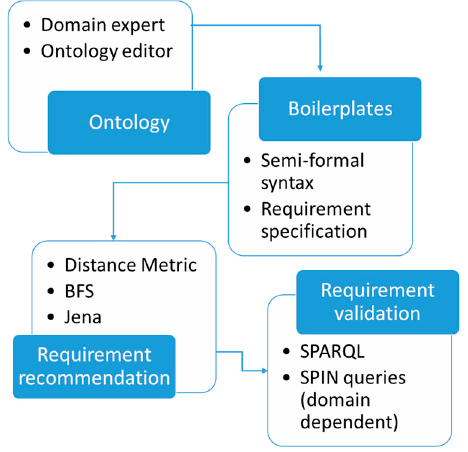
Figure 2. Abstract architecture of SENSE system.